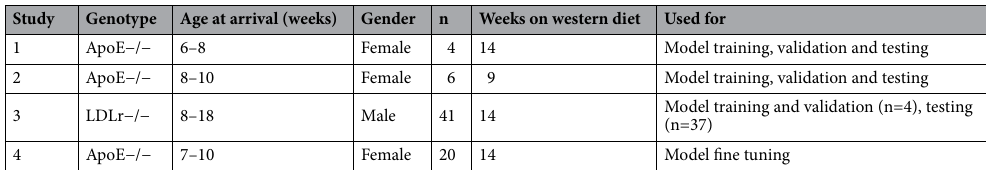
Table 1. Overview of studies included for training, validation and testing of the plaque